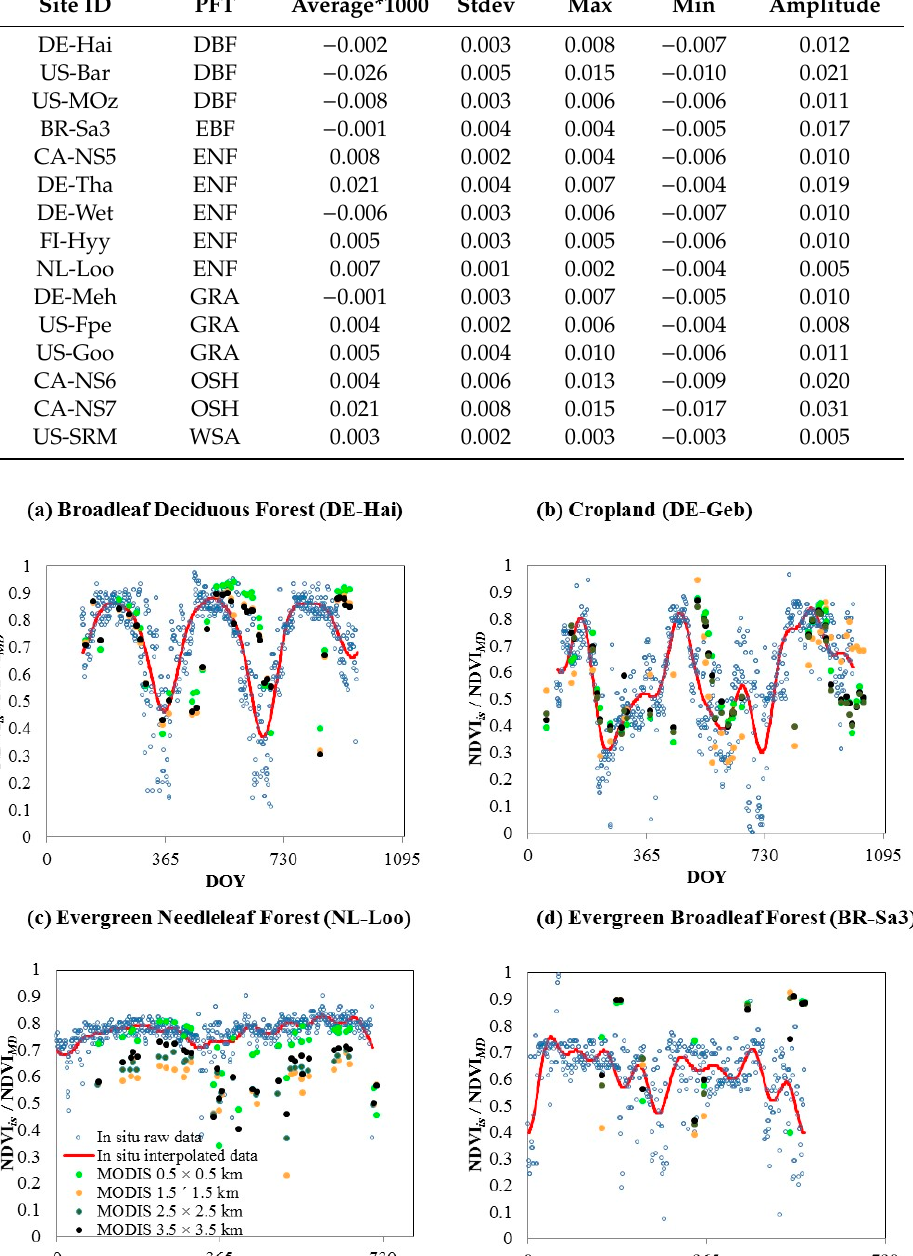
Table 5. Spatial heterogeneity index (SHI) for different flux sites. Letters in bold indicate SHI for heterogeneous sites.